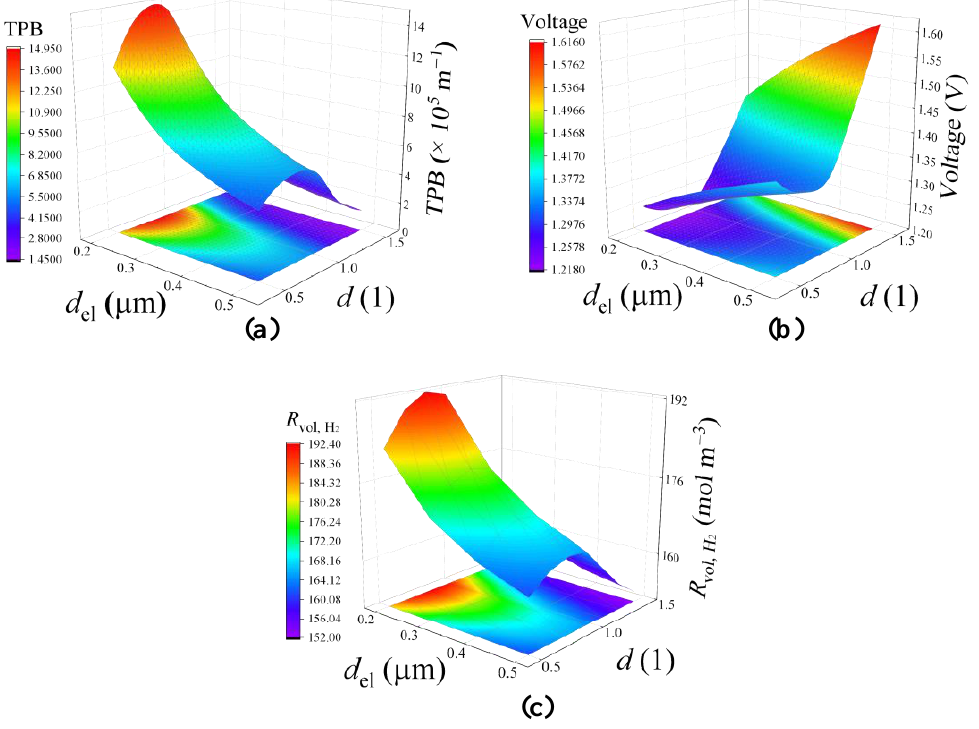
Figure 8. The effect of different particle diameters on: ( a ) the distribution of the volumetric percolation TPB area; ( b ) applied voltage of the IT-SOEC unit; and ( c ) hydrogen production rate per unit electrode volume.